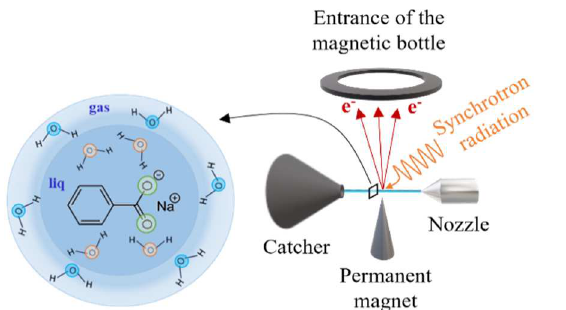
Fig. 1. Scheme of the liquid micro-jet devise coupled with the magnetic bottle electron spectrometer together with a cut view of the liquid and a schematic representation of all types of oxygen atoms present during the